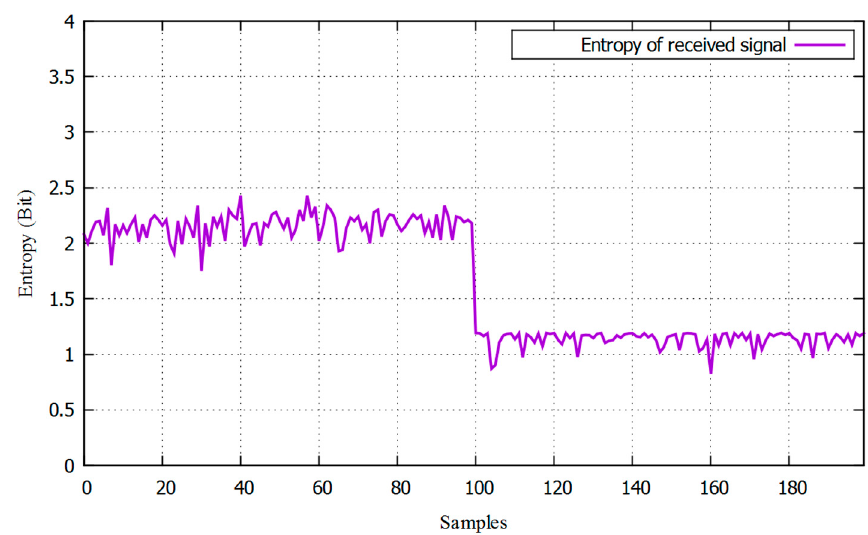
Figure 7. Entropy of the received signal.